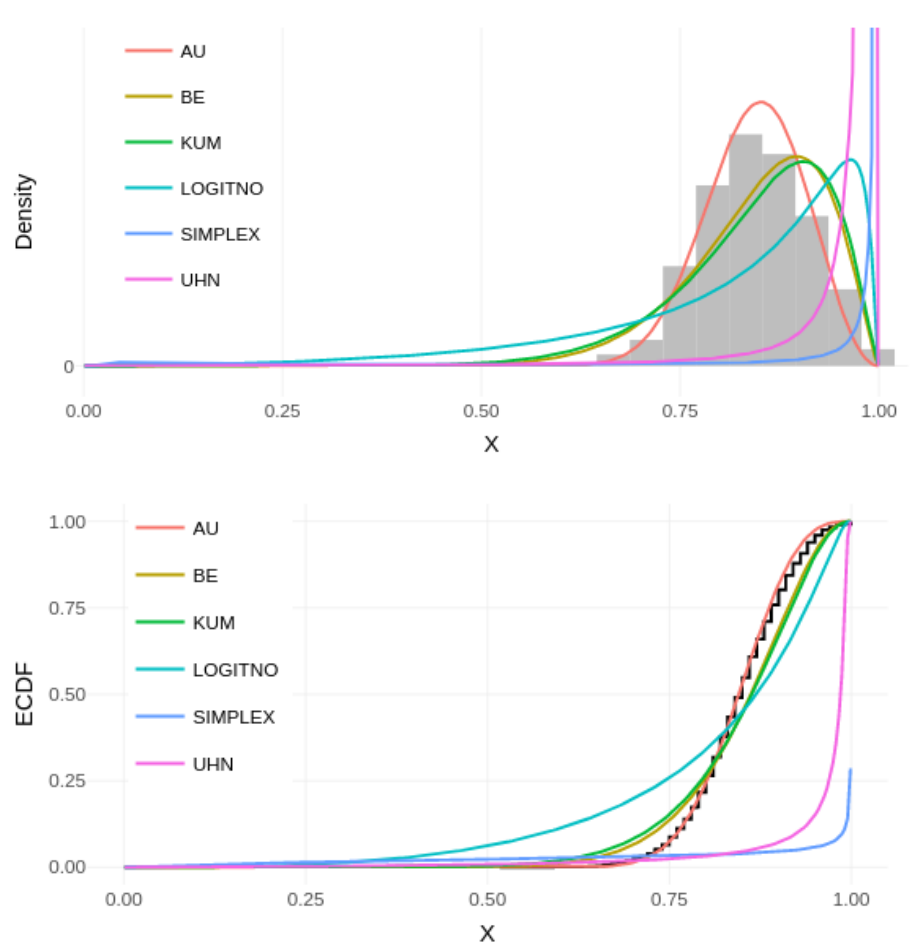
Figure 5. Estimated densities superimposed to the histogram ( top-chart ), and estimated CDFs superimposed to the ECDF ( bottom-chart ) (relative air humidity data).